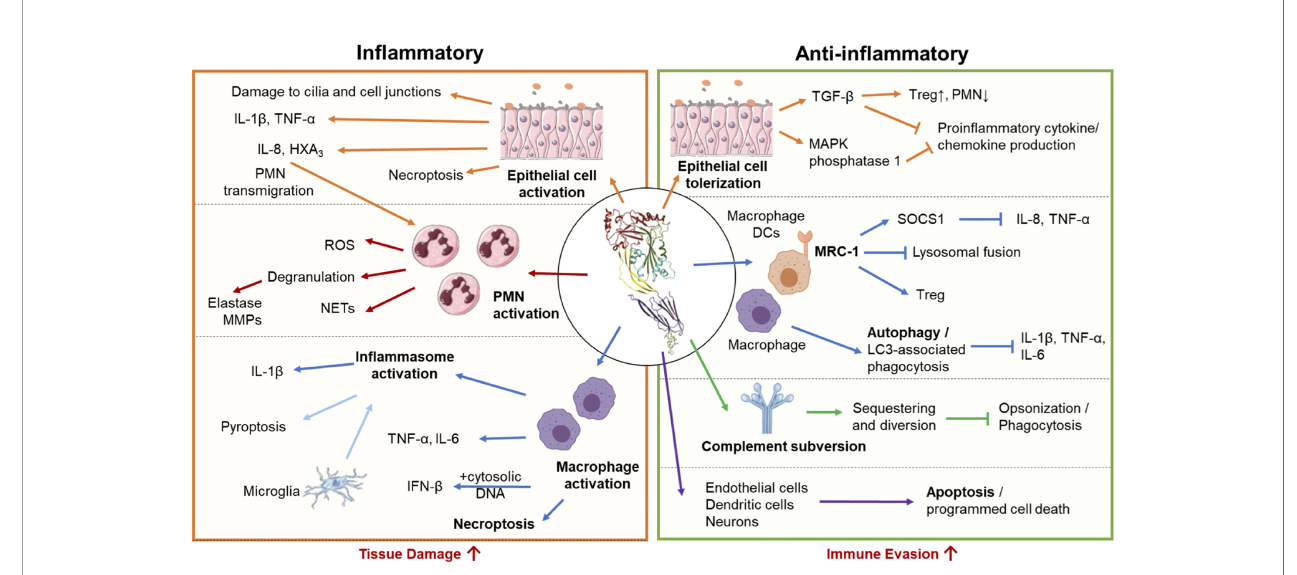
FIGURE 4 | Pro-in fl ammatory and anti-in fl ammatory host responses to PLY. S. pneumoniae triggers both pro-in fl ammatory and anti-in fl ammatory responses depending on interacting host cell type and infection context. Left Panel: In excess, pro-in fl ammatory actions of PLY enhance tissue damage and promote bacterial spread. In epithelial cells, PLY induces production of pro-in fl ammatory cytokines and chemokines, promoting neutrophil transmigration and compromising epithelial barrier function. PLY-stimulated neutrophils engage in a wide range of effector functions, including degranulation, reactive oxygen species (ROS) production, and neutrophil extracellular trap (NET) release, many of which propagate in fl ammatory tissue damage and are associated with severe pathology in the lung. PLY can activate macrophages independently or in conjunction with other co-stimulants to cause the release of pro-in fl ammatory cytokines and chemokines. Macrophages can also be activated by PLY-dependent in fl ammasome activation, which in bone marrow-derived macrophages leads to IL-1 b -mediated in fl ammation, and in microglia, pyroptotic cell death. PLY is also a potent inducer of macrophage necroptosis, often leading to acute tissue injury. Right Panel: Anti-in fl ammatory activities of PLY downregulate immune responses and may aid bacterial evasion. During pneumococcal colonization and early stages of lung infection, PLY suppresses in fl ammatory cytokine production by airway epithelial cells and enhances recruitment ofT regulatory cells, promoting unchecked bacterial colonization. Internalization of PLY by alveolar macrophages and dendritic cells via the mannose receptor MRC-1, or, in bone marrow derived macrophages, PLY triggered LC3- associated phagocytosis, suppress the production of in fl ammatory cytokines. To avoid complement mediated detection and opsonization, PLY acts as a decoy molecule to sequester complement proteins. Finally, PLY triggers apoptosis in a wide range of cell types, including endothelial cells, neurons, and dendritic cells, allowing for non- in fl ammatory removal of these cell